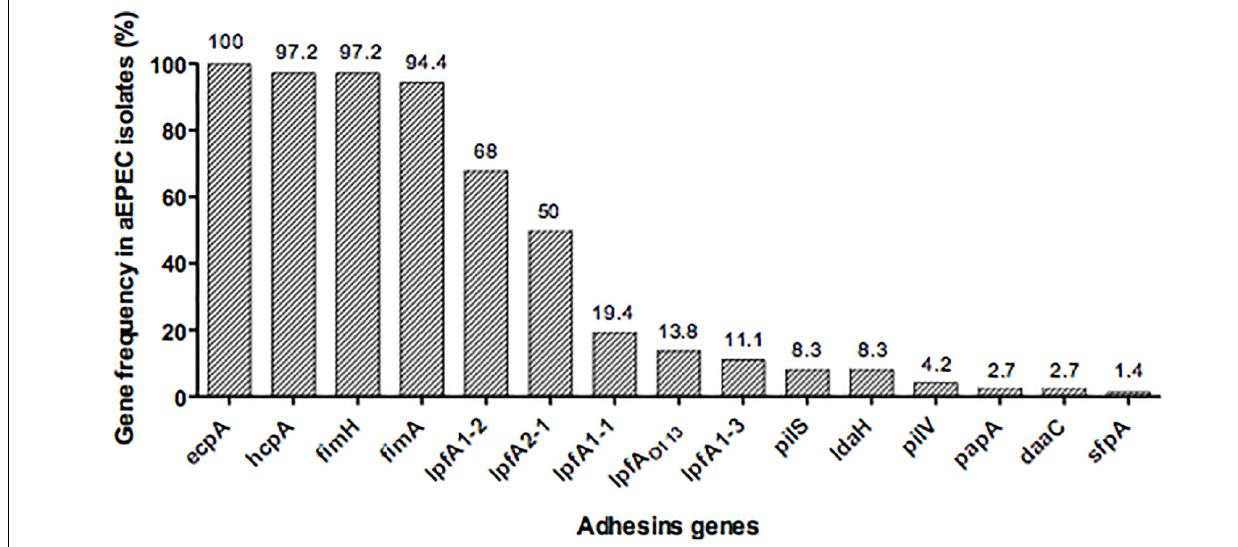
FIGURE 1 | Distribution of the frequency of fimbrial genes among 72 aEPEC strains